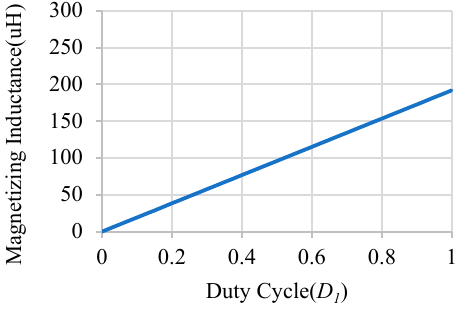
Figure 10. Lm 1, BCM in step-down mode.